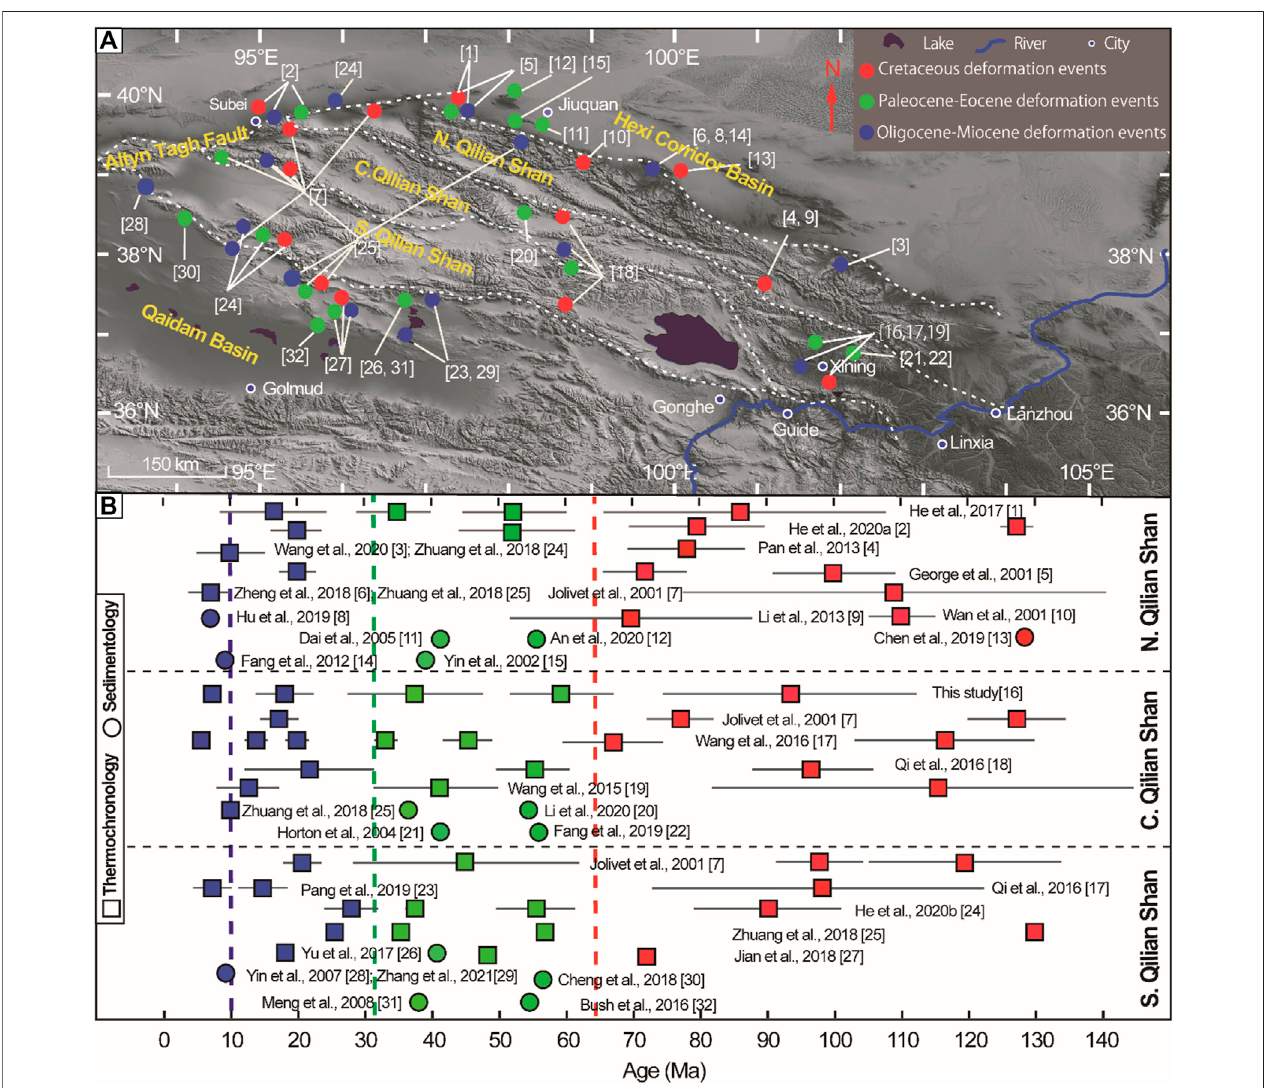
FIGURE 5 | (A) Colored dots from thermochronology and sedimentology compilation studies on the South, Central, and North Qilian Shan; the ages are denoted bypointsofdifferentcolorsrangingfromCretaceoustoEarlyPliocene.ThedashedwhitelinesseparateSouth,Central,andNorthQilianShanareas(modi fi edfromFeng and He, 1996). (B) Temporal distribution ofthelateMesozoic – Cenozoic tectonic events recorded intheQilian Shan, asconstrained bythermochronology (squares) and sedimentology (diamonds).